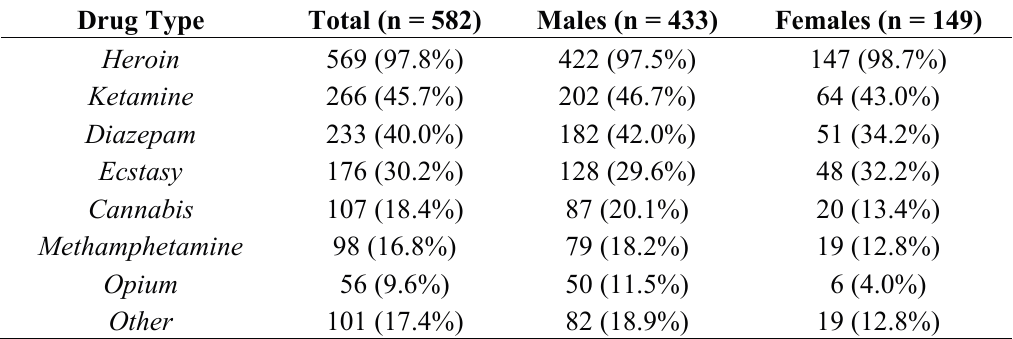
Table 2. The major drug types among those who had ever used drugs in